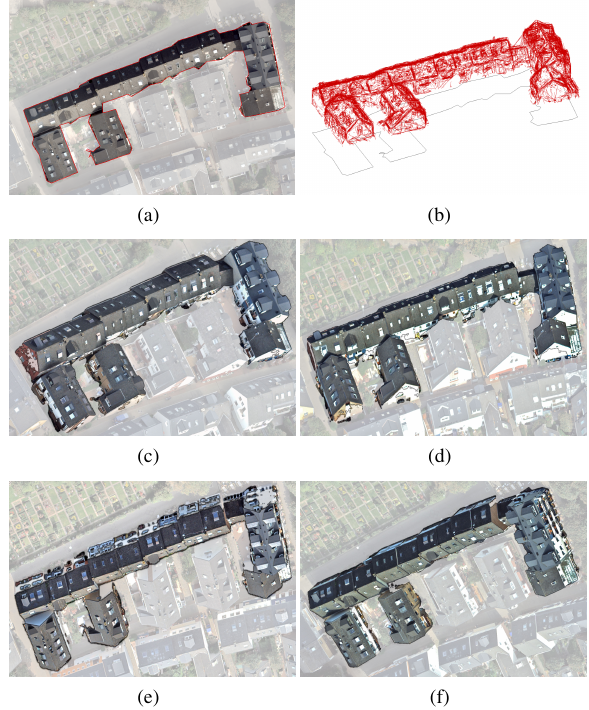
Figure 1. Source data (a) Vertical orthomosaic with superimposed building outline polygon (b) 31873 3D line segments from all orthomosaics (c-f) Oblique orthomosaics showing the polygonal content as translucent